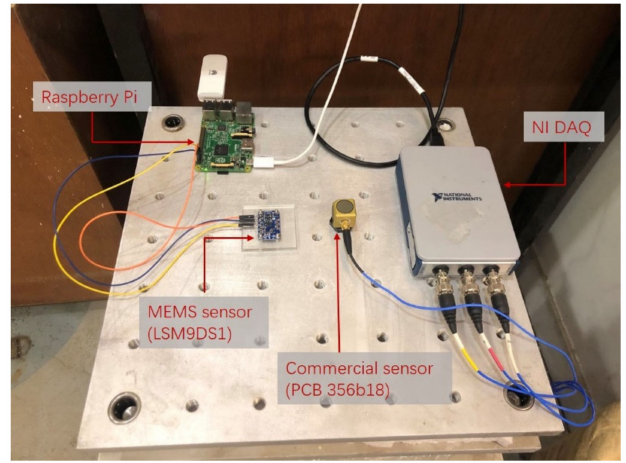
Figure 10. Shake table test